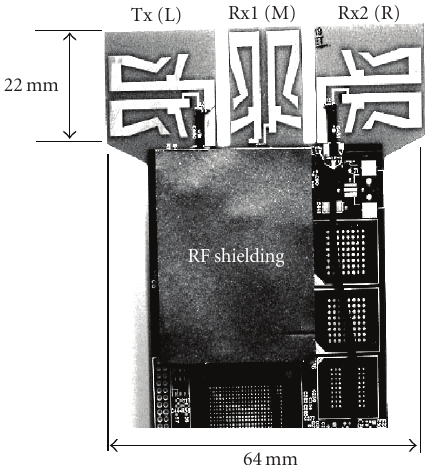
Figure 17: Picture of the SDR platform with three